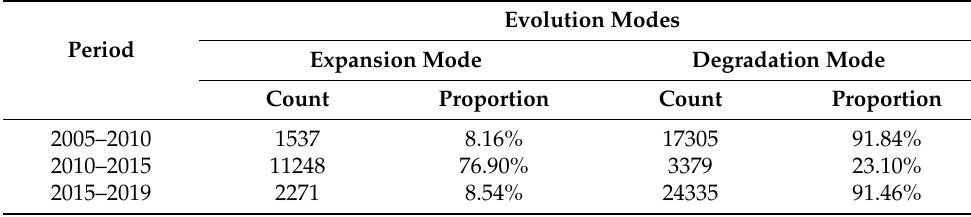
Table 3. Count and proportion of evolution modes.